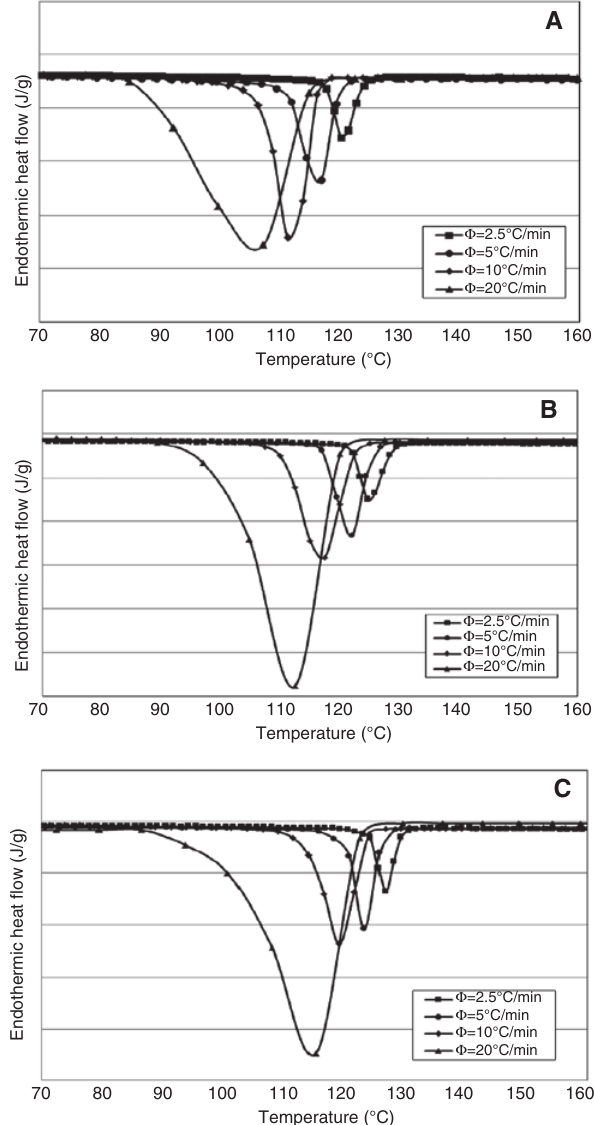
Figure 2: Differential scanning calorimetry (DSC) thermograms of non- isothermal crystallization of (A) neat polypropylene (PP), (B) PP-25 date